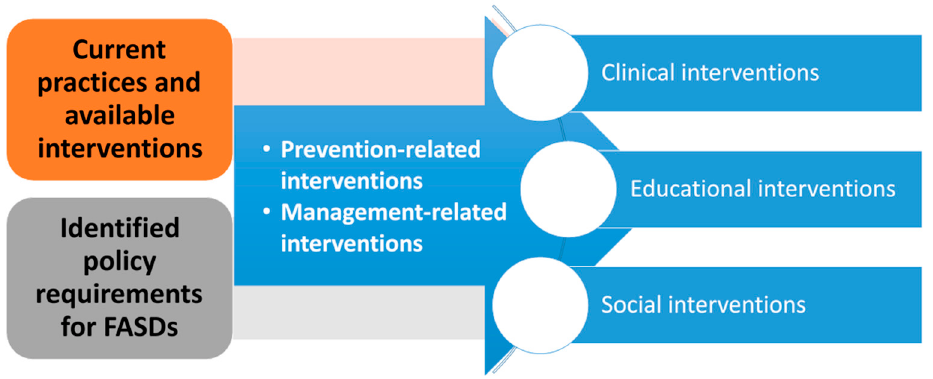
Figure 1. A working analytic framework.